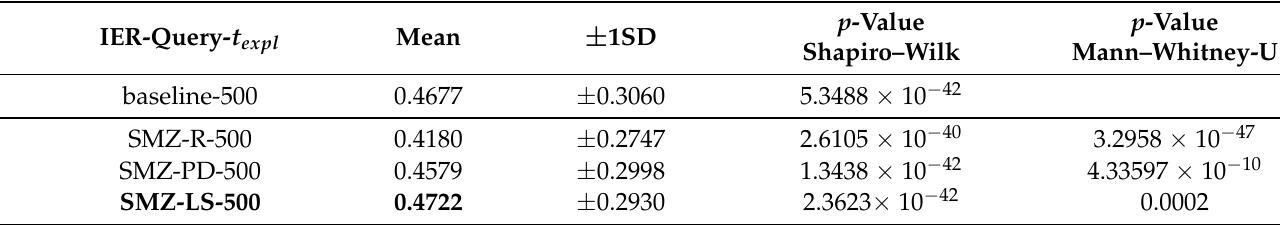
Table A2. A summary of the results of experiment 2 with state-encoding CE. Bold mean entries show a better performance in comparison to the corresponding baseline; bold IER-Query- t expl entries indicate statistically significant superior performance compared to the